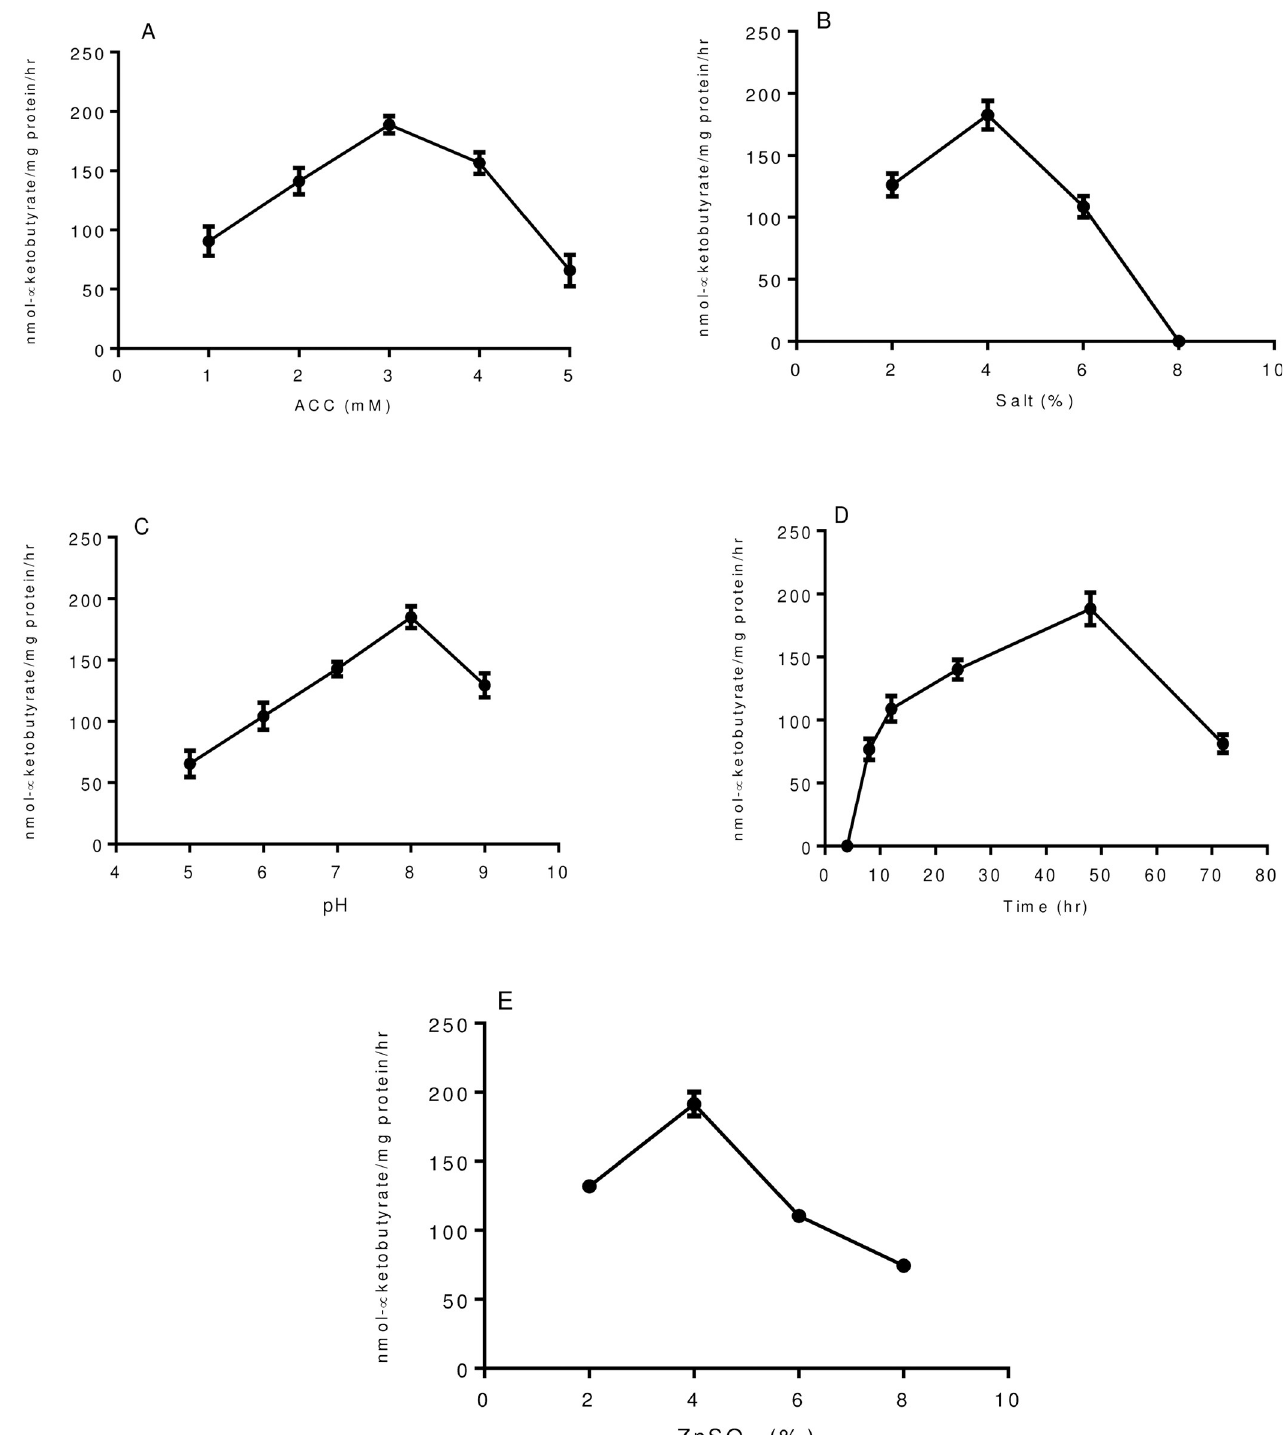
Fig 2. Pattern of ACCD activity of isolate ZNP-4 under varying physiological conditions (A) substrate (ACC) concentration (B) at different salt (NaCl) concentrations (C) varying pH conditions (D) under different time period (E) different concentration of ZnSO 4 . Each value represent the mean of three replicates ± SD (n =